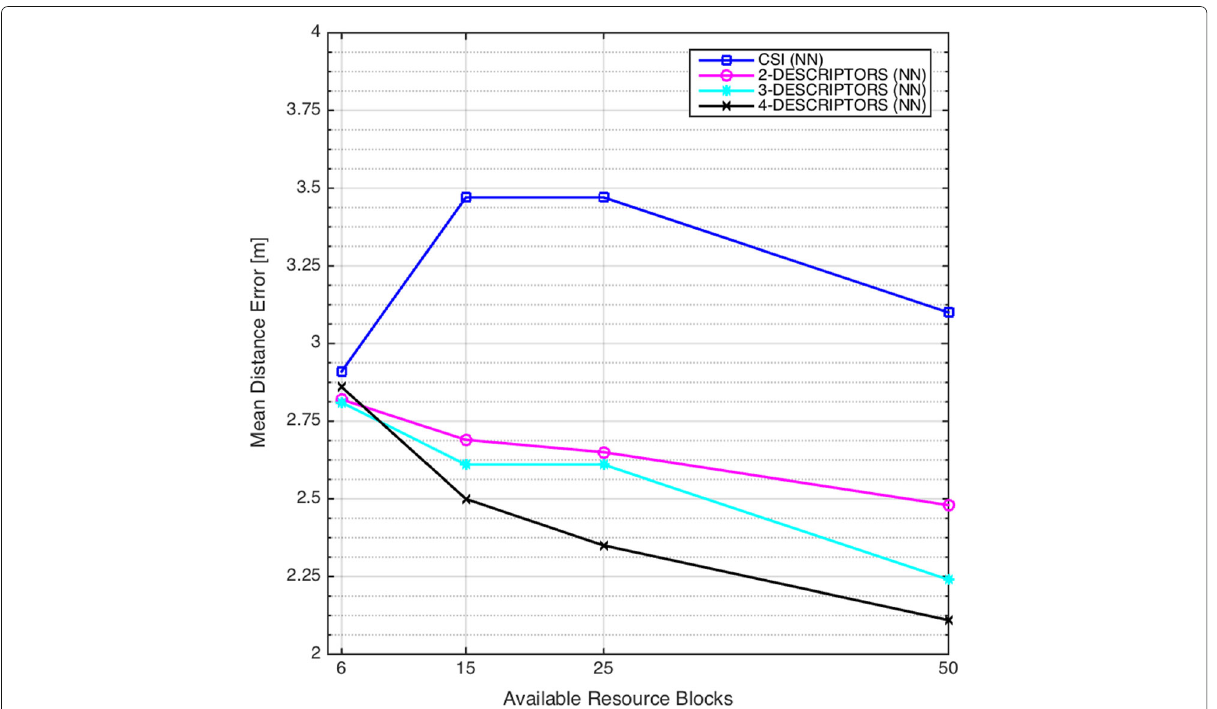
Fig. 11 Effect of bandwidth increase on localization performance. Mean Distance Error with respect to the LTE signal bandwidth in terms of available resource blocks